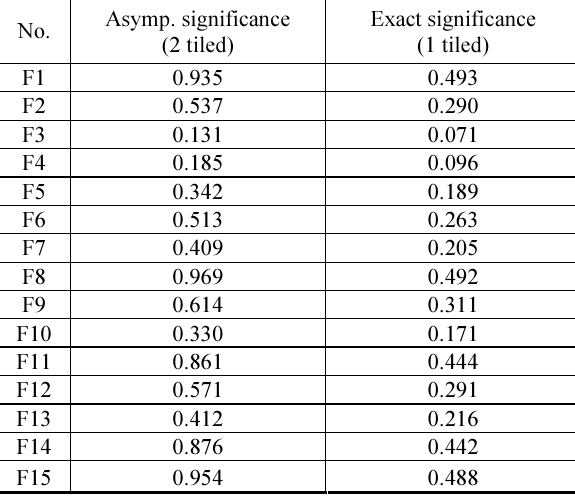
Table 4. Mann Whitney U test of Driving